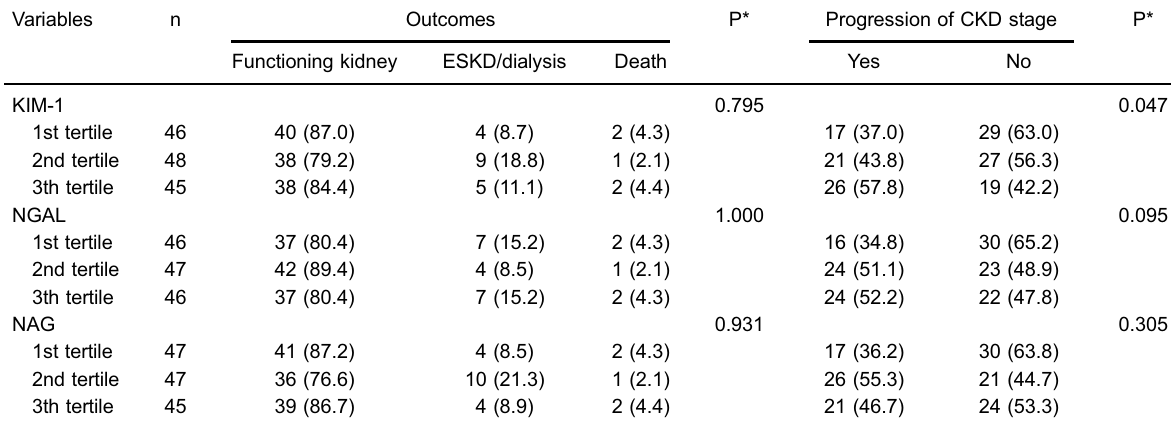
Table 4. Association between biomarkers (strati fi ed into tertiles) and outcomes in patients not on dialysis at baseline. Variables